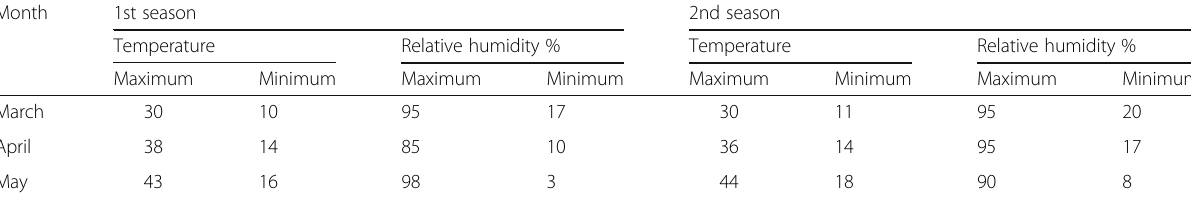
Table 1 Average of monthly maximum and minimum air temperature and relative humidity during the two seasons of study